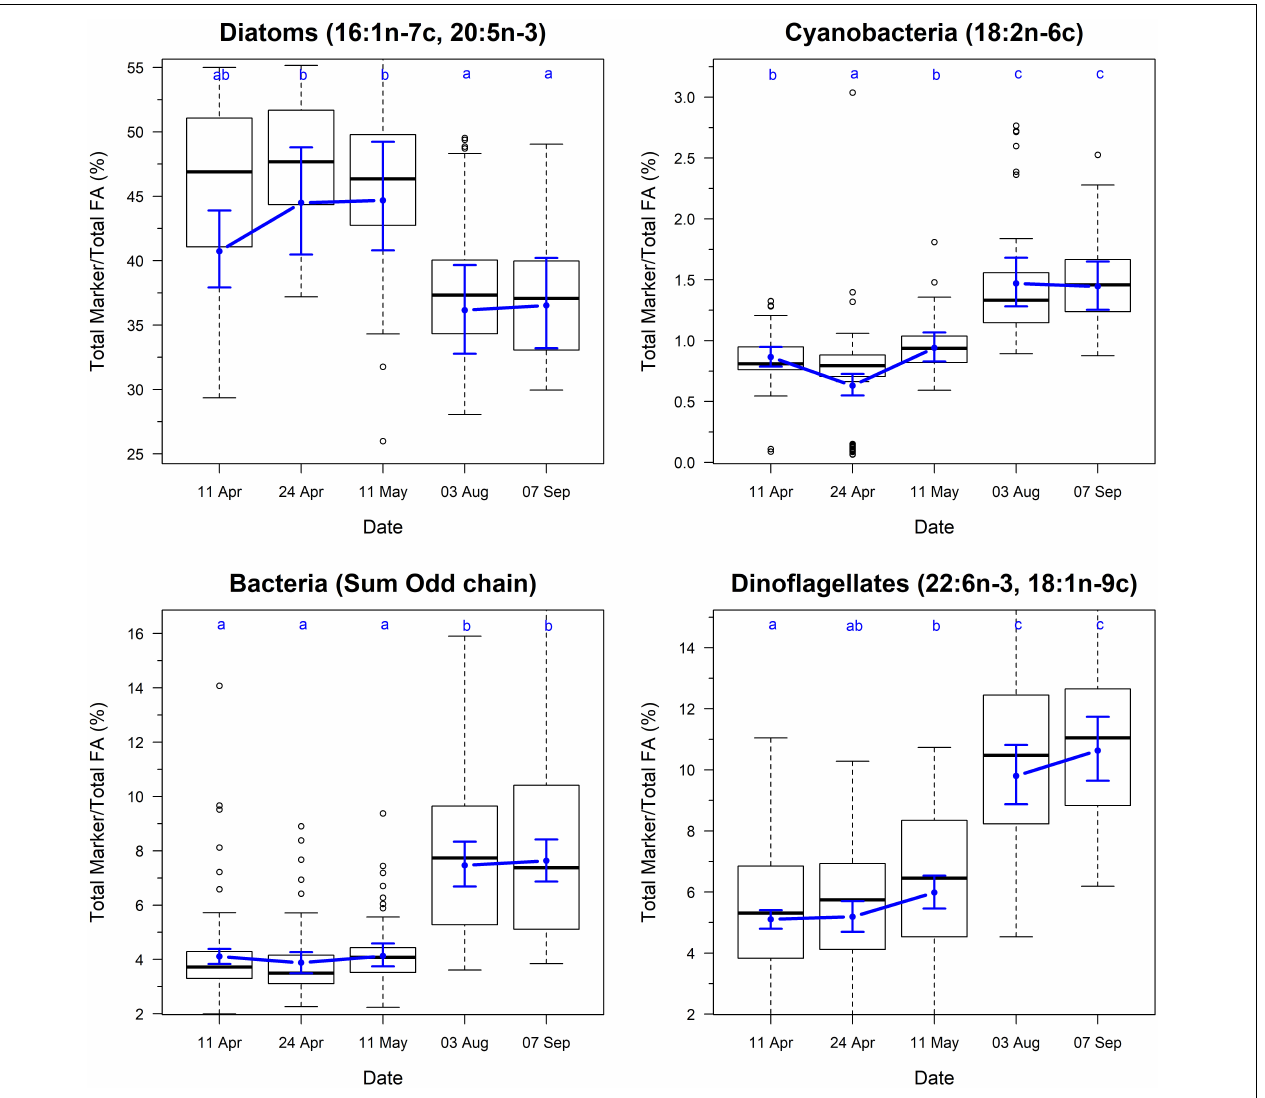
FIGURE 3 | Temporal changes in the ratio of fatty acid groups and chemotaxonomic markers on Roberts Banks mudflats located on the Fraser River estuary, British Columbia, April-September 2017. Note that y -axis for biomarker plots extend from 0.025 to 0.975 percentiles of each measure to avoid compression of scale from outliers. Box plots represent the distribution of observed values, where midline is the median, with the upper and lower limits of the box being 75th and 25th percentiles. Whiskers extend up to 1.5 × the interquartile range, and outliers are depicted as points. Blue circles indicate predicted means from linear mixed effects models, and bounds are 95% prediction intervals from fixed effects. Letters indicate groupings that are not statistically significantly different according to Tukey’s pairwise